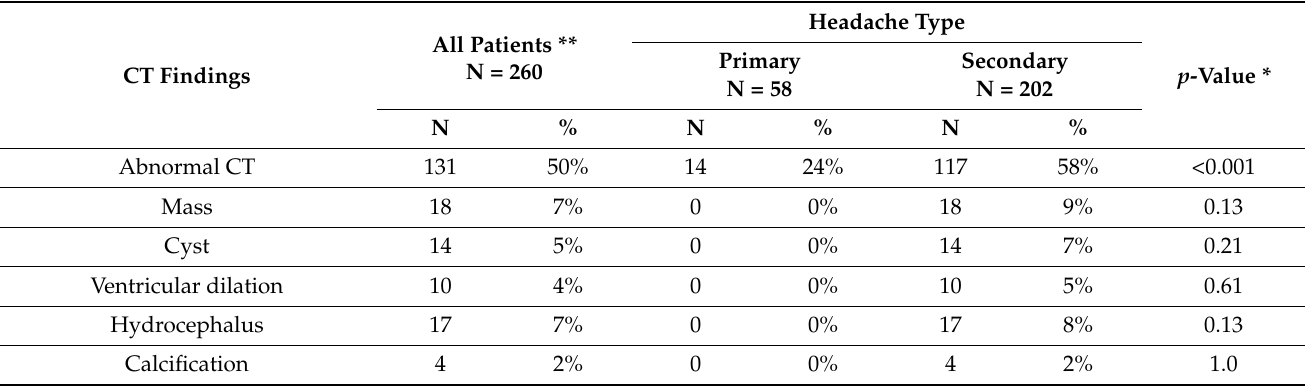
Table 3. Computed tomography and magnetic resonance imaging